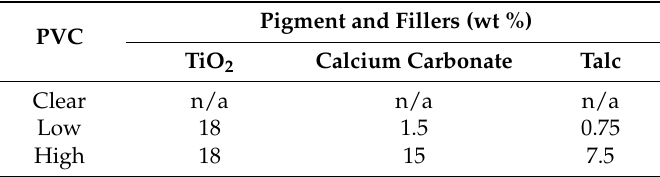
Table 4. Pigment and fillers loading for the different